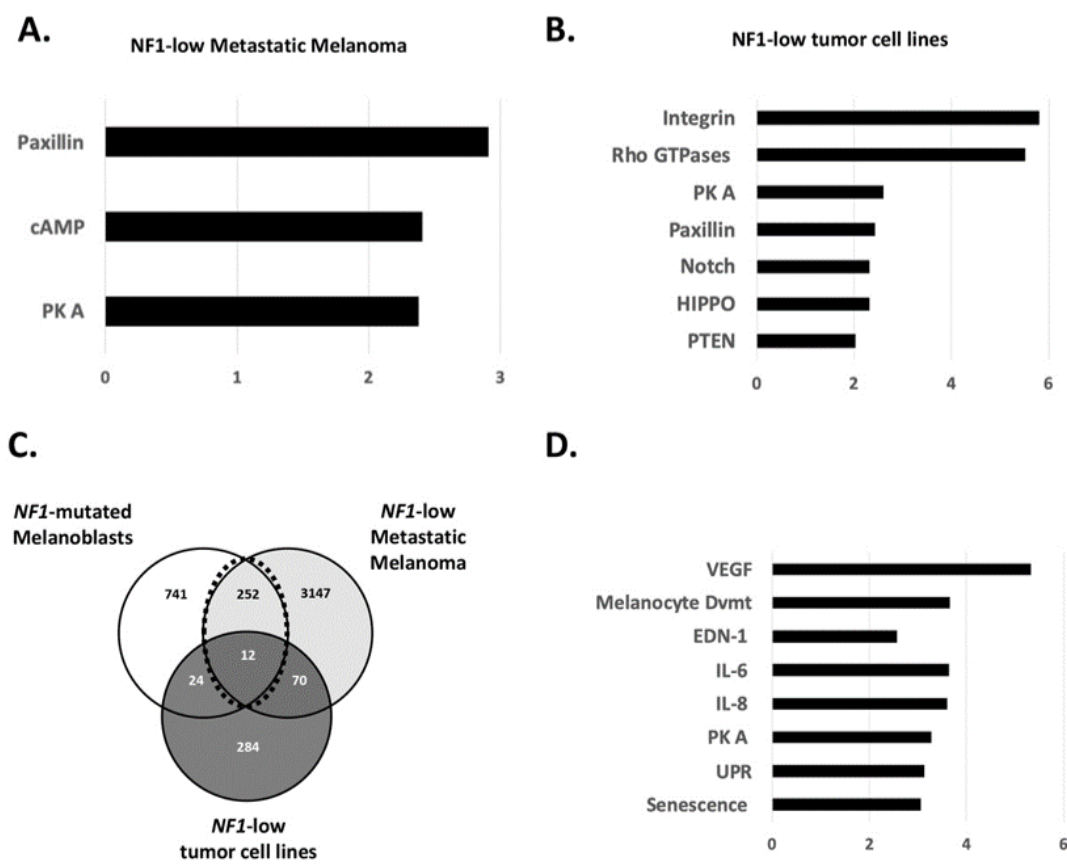
Figure 2. Role of NF1 in the gene’s regulation of melanoblasts and melanoma. ( A ) Main regulated signaling pathways in NF1 -low expressing metastatic melanoma. ( B ) Main regulated signaling pathways in NF1 -low expressing tumor cell lines. ( C ) Venn diagram including NF1 -low expressing metastatic melanoma, NF1 -mutated melanoblasts, and NF1 -low expressing tumor cell lines. ( D ) Common regulated signaling pathways in NF1 -mutated melanoblasts and NF1 -low expressing metastatic